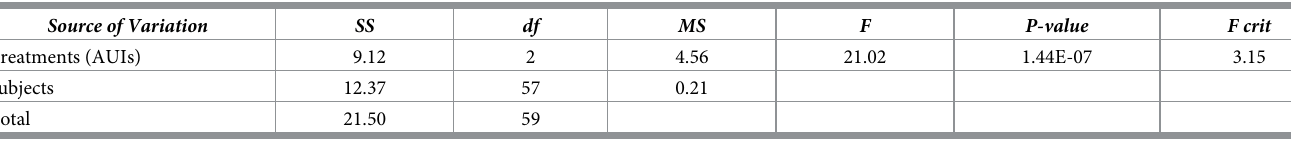
Table 28. One-way ANOVA—Viewpoint #10.